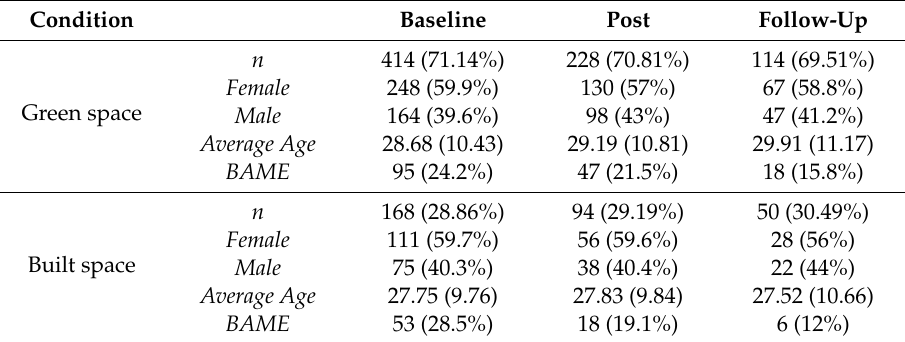
Table 1. Participant demographics per condition at baseline, post and